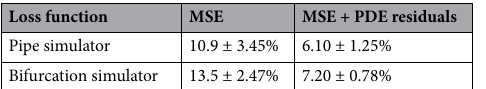
Table 1. MRE comparison between simulators using different loss